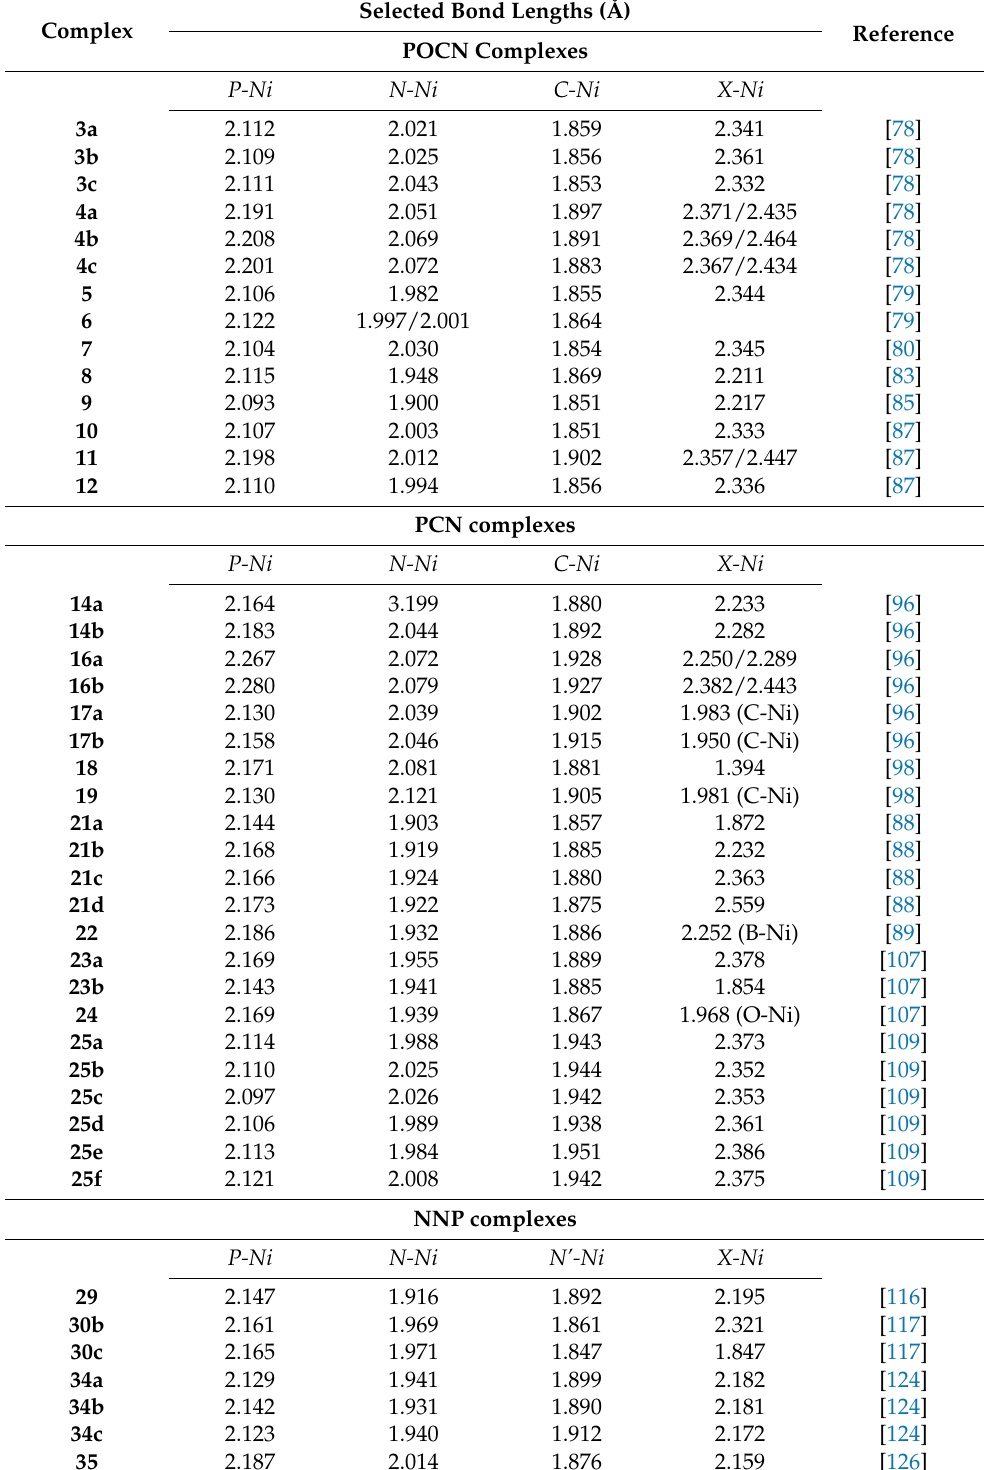
Table A1. Selected bond lengths (Å) of unsymmetrical nickel pincer complexes presented in this review.